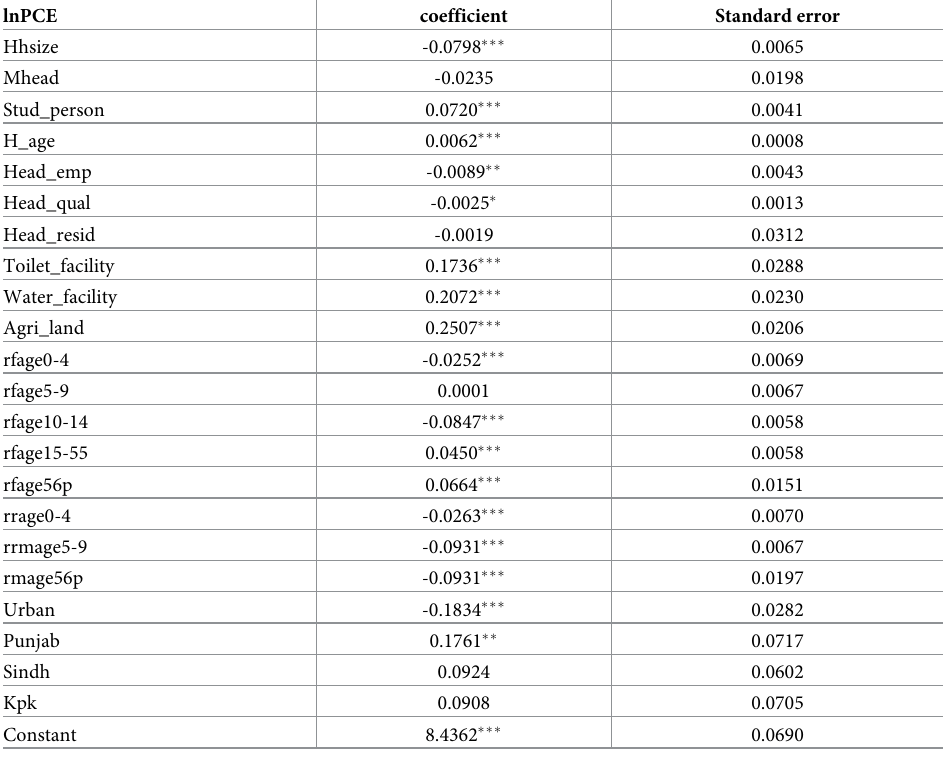
Table 6. OLS Regression estimates with simulated error for